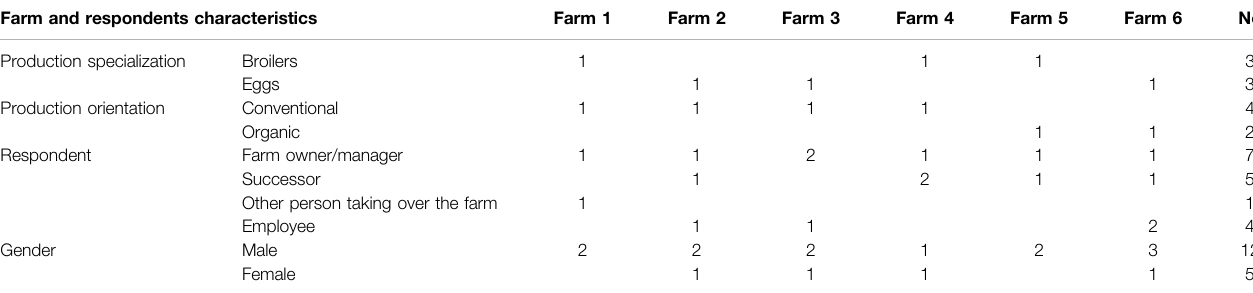
TABLE 1 | Characteristics of farms and respondents participating in the semi-structured interviews. Farm and respondents